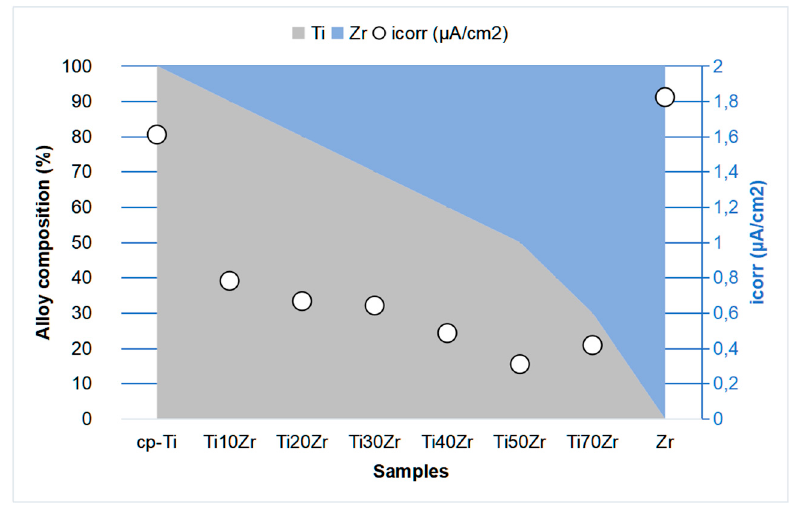
Figure 1. Corrosion density current dependence of TixZr alloy as a function of Zr content.